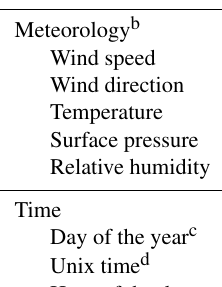
Table 1. Random forest predictor variables for hourly ozone and NO 2 concentrations a